Question: Sum up the contents of this chart in one sentence.
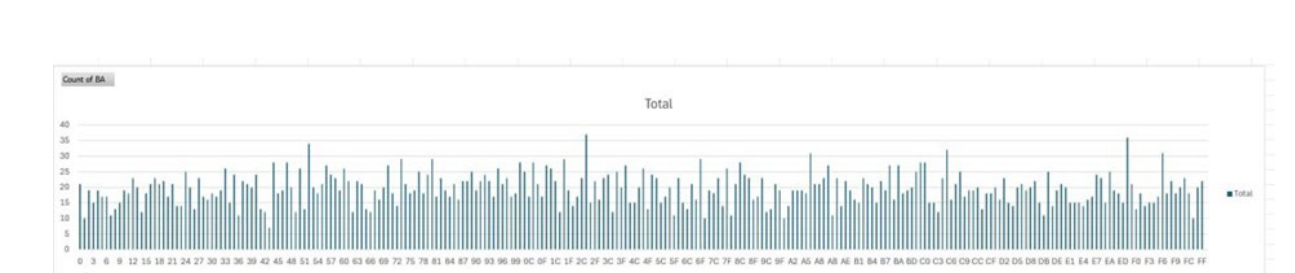
Answer: Statistical distribution before RNG value is converted to the chosen dice range.